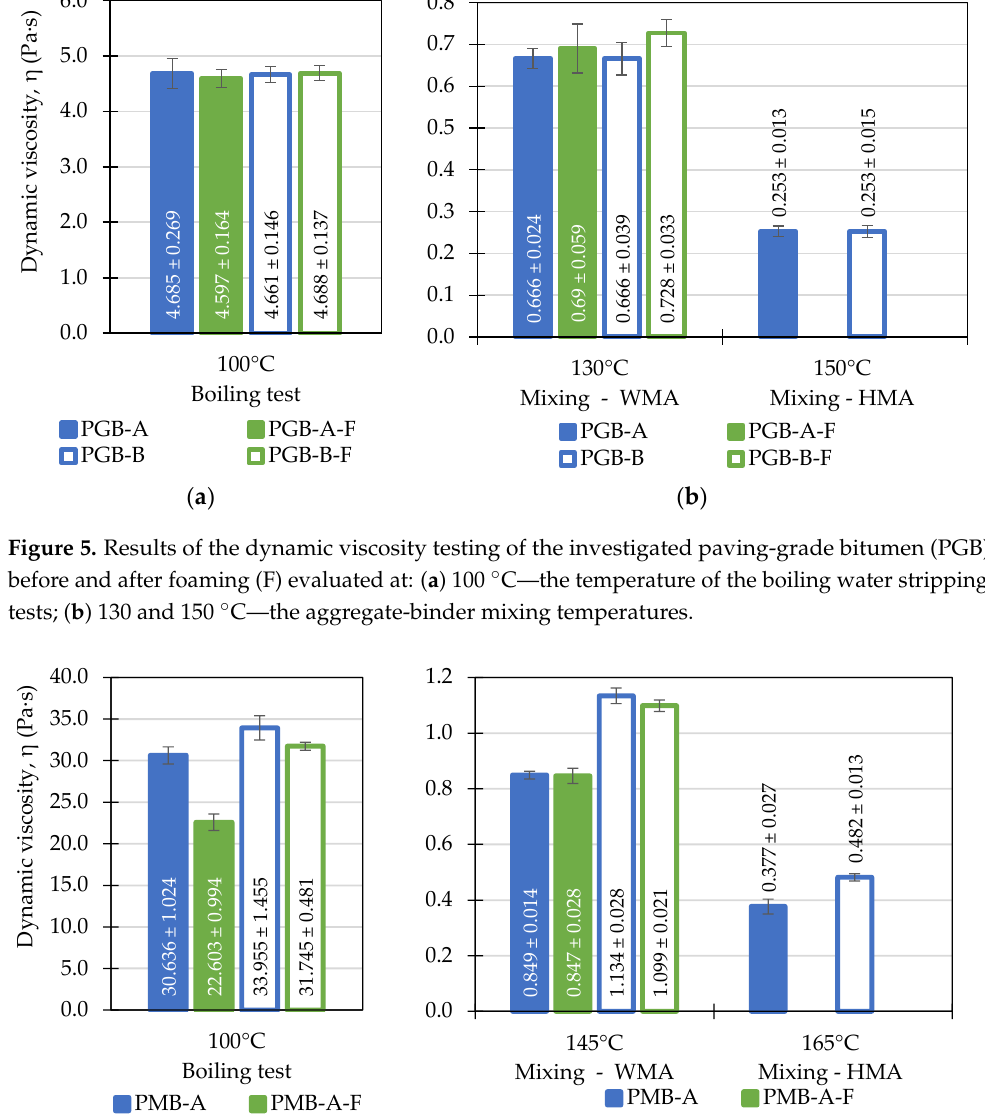
Figure 7. Values of the structural indices calculated based on the ATR-FTIR spectra of the investi- gated binders.